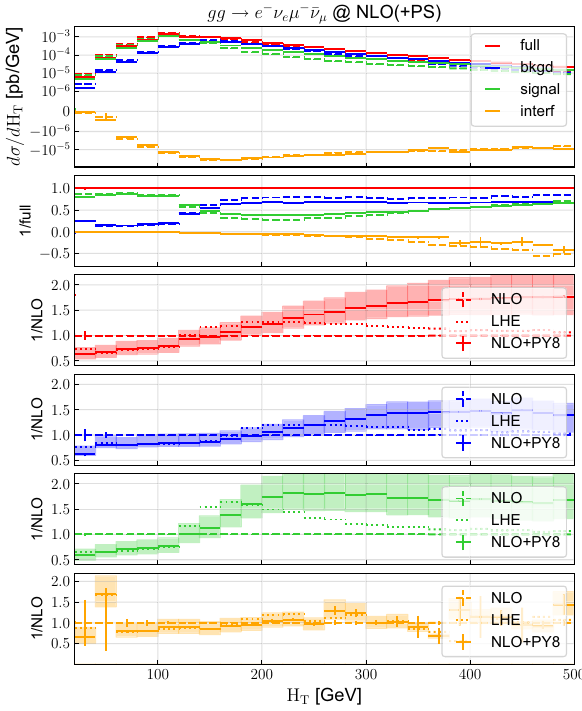
Fig. 8 Differential distribution in H T in gg → e + ν e μ − ¯ ν μ at NLO matchedto PYTHIA 8